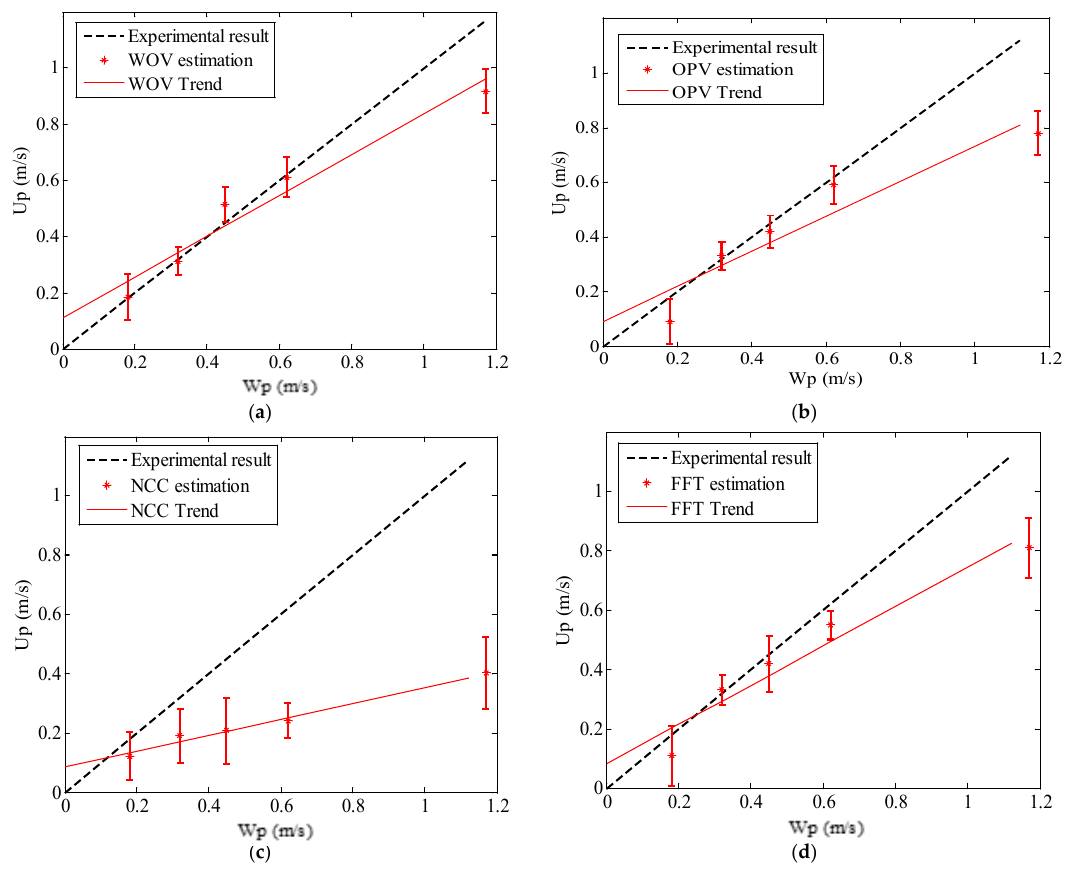
Figure 6. Estimated nozzle velocity compared to the measured velocity for ( a ) OPV. ( b ) FFT. ( c ) normalized FFT. and ( d ) WOV velocimetries.